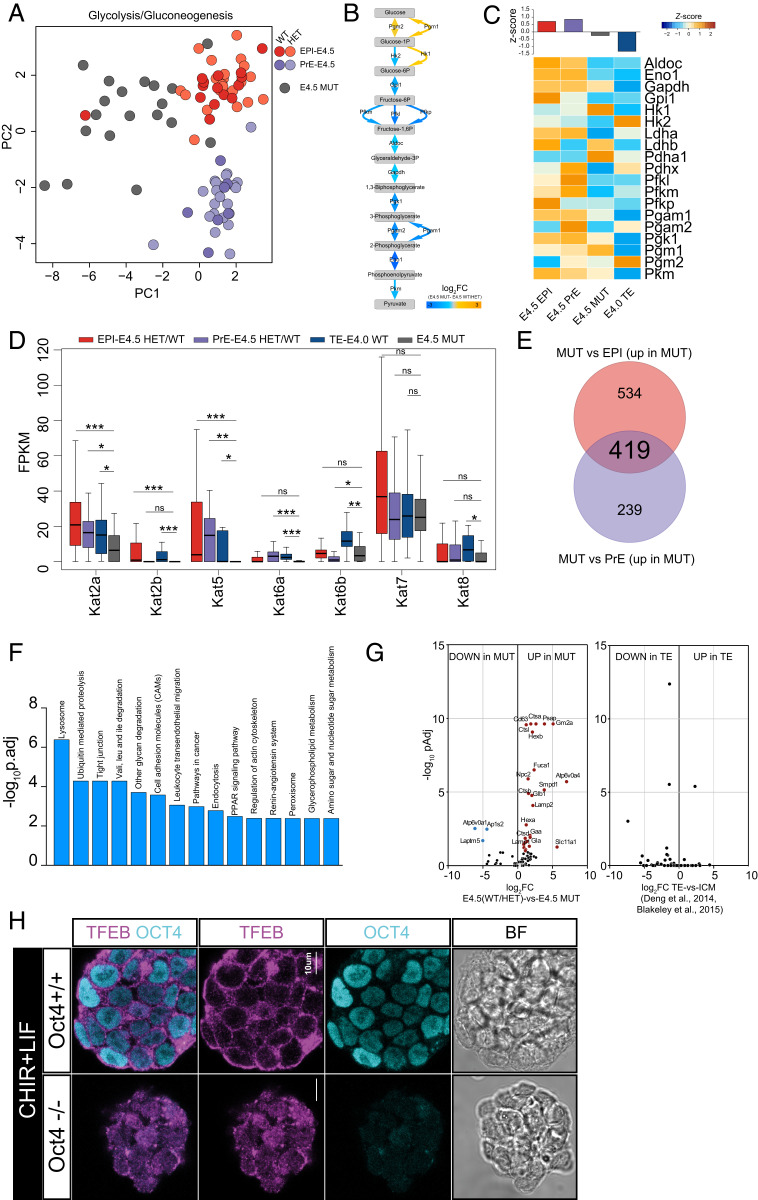
(A) PCA plot of E4.5 WT/HET and MUT cells computed with genes in glycolysis/gluconeogenesis KEGG pathway. (B) Glycolysis pathway with the associated enzymes (arrows) colored by the ratio between E4.5 WT/HET and MUT cells and (C) heat map of the associated enzymes. (D) Box plot of Kats gene expression value in E4.5 EPI/PrE WT/HET, E4.0 TE, and E4.5 MUT (Student’s t test; *P < 0.05, **P < 0.01, ***P < 0.001). (E) Number of variable genes between E4.5 WT EPI/MUT and E4.5 WT PrE/MUT. (F) Enrichment of KEGG pathways computed with 419 common variable genes between MUT and E4.5 EPI/PrE. (G) Volcano plot of lysosomal genes variable between E4.5 WT/HET and E4.5 MUT and between WT TE and WT ICM. (H) Confocal analysis of TFEB localization in OCT4+/+ and OCT4−/− ESCs cultured in CHIR + LIF.